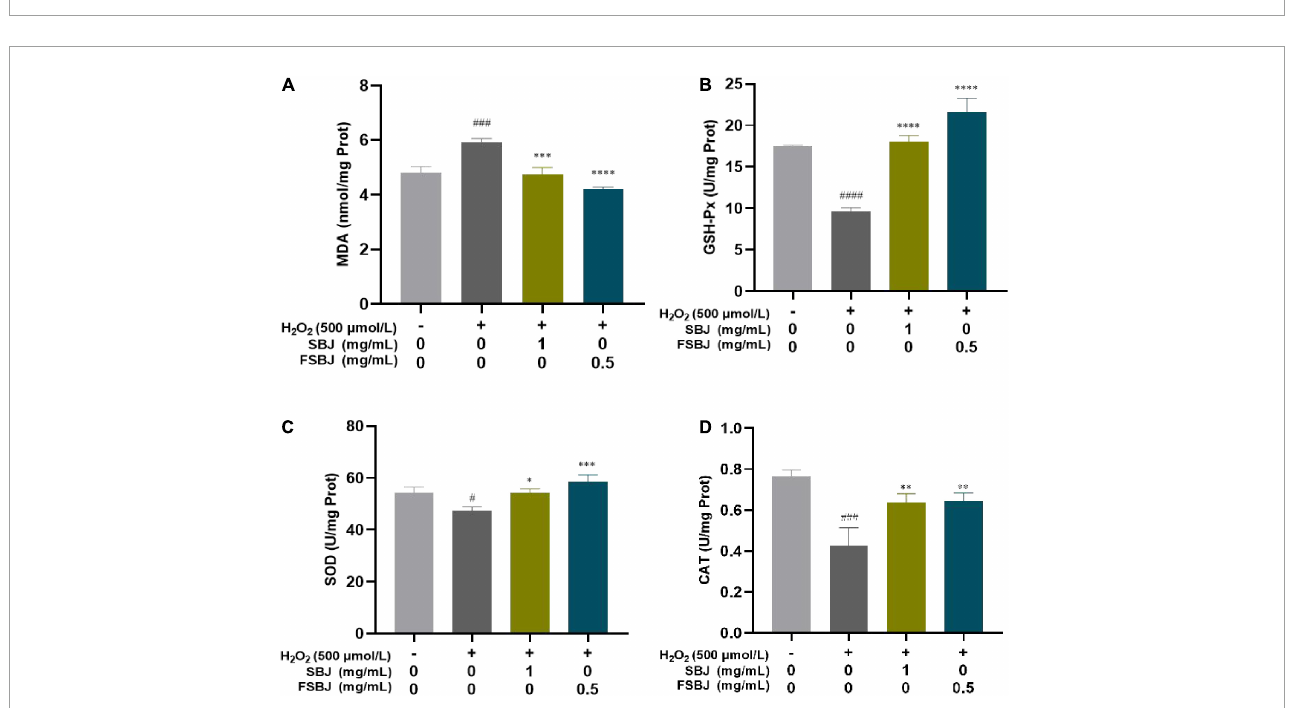
FIGURE9 The effect of FSBJ on the oxidative stress indexes of C2C12 cells compared to the control group (no H 2 O 2 , # p < 0.05, ### p < 0.001, and #### p < 0.0001) and damaged group (non-SBJ and FSBJ-supplemented, * p < 0.05, ** p < 0.01, *** p < 0.001, and **** p < 0.0001). (A) Effects of FSBJ on MDA contents; (B) effects of FSBJ on GSH-Px activity; (C) effects of FSBJ on SOD activity; and (D) effects of FSBJ on CAT